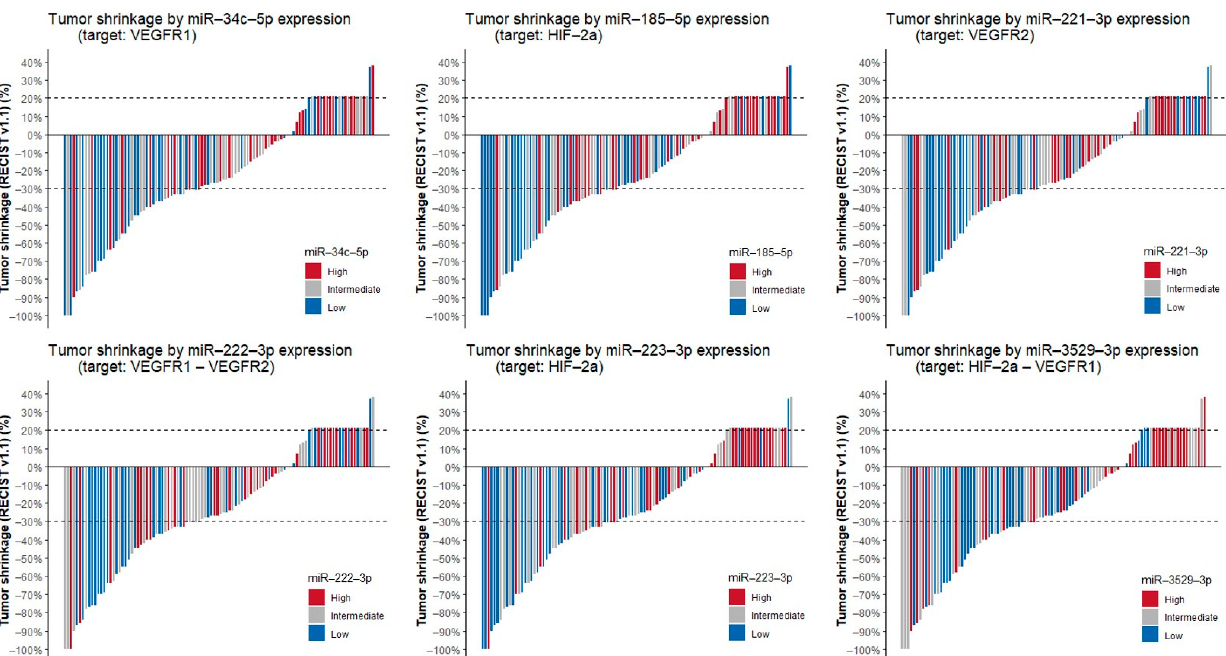
Figure 2. Waterfall plots displaying tumor shrinkage by miRNA expression per sample as evaluated by RECIST v1.1 criteria. For visual representation, miRNA expression levels were divided into high, intermediate and low expression by terciles of the respective miRNA expression levels. Abbreviations: miR = microRNA, VEGFR1 = vascular endothelial growth factor receptor 1, RECIST v.1.1 = Response Evaluation Criteria In Solid Tumors, version 1.1, HIF-2 α = hypoxia-induced factor 2 α , VEGFR2 = vascular endothelial growth factor receptor 2.